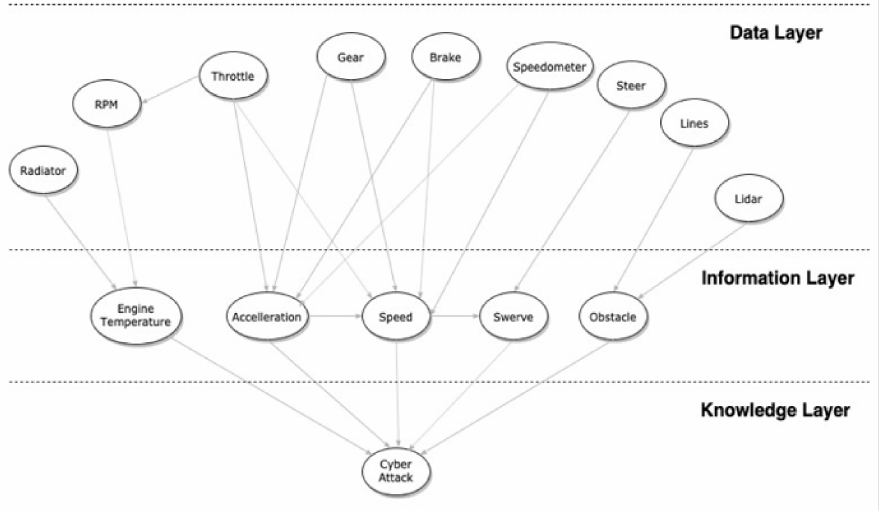
Figure 4. The obtained Bayesian